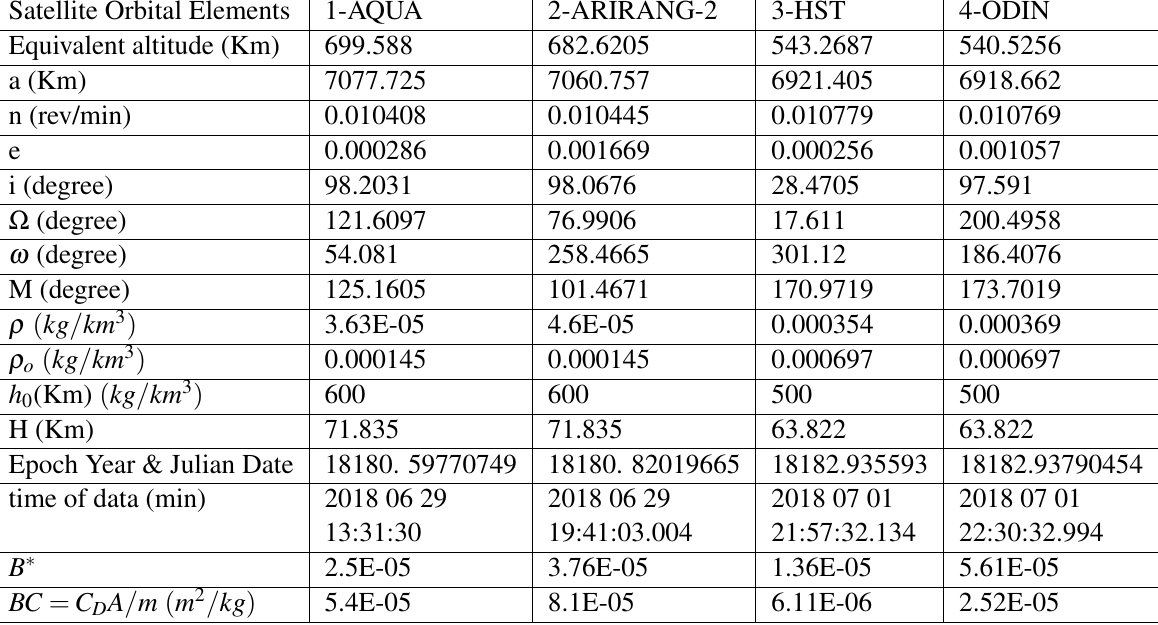
Table 1 Norad Two - Line Element Sets For The Satellites AQUA, ARIRANG-2, HST and ODIN Satellite Orbital